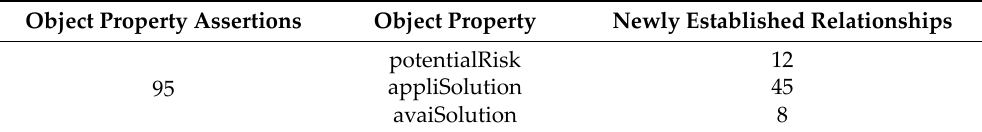
Table 11. Statistics of decision results of expressway